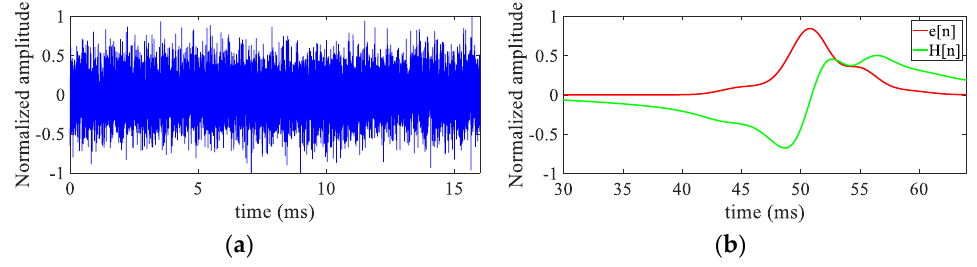
Figure 14. The analysis of peak detection under Gaussian noise, ( a ) SNR = − 20 dB, ( b ) peaks detec- tion.